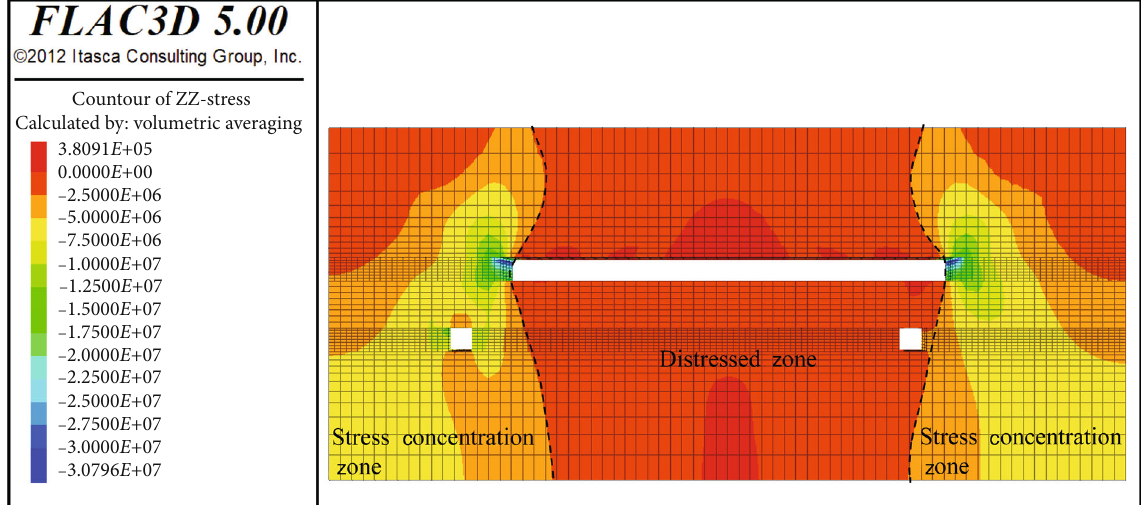
Figure 13: The vertical stress fi eld of strata after the above-gob area in stabilization.